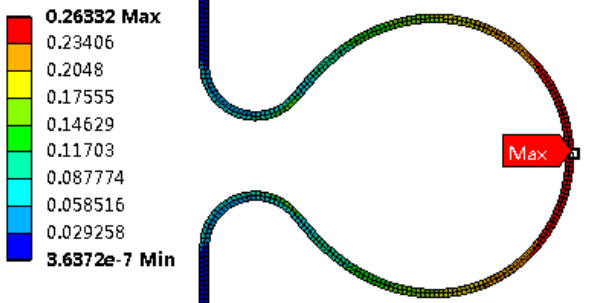
Figure 10. Von Mises strain at the wave before unloading.